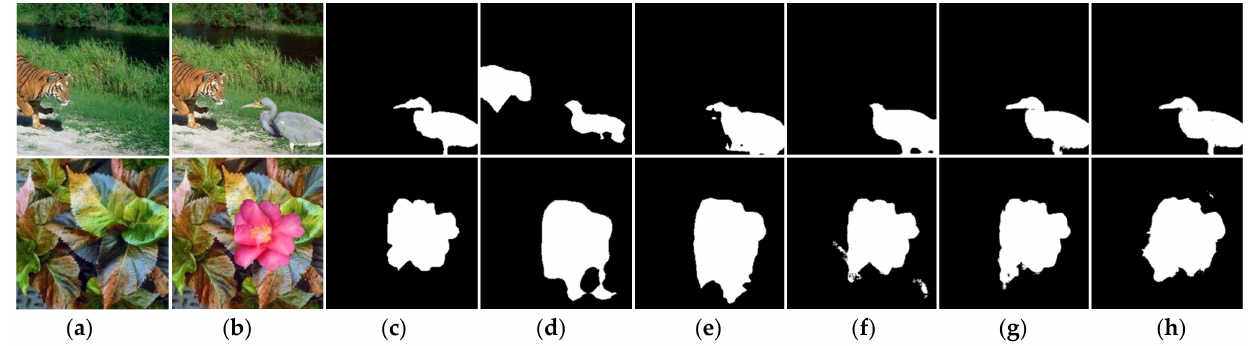
Figure 4. Ablation results of two images from CASIA1.0: ( a ) real images, ( b ) tampered images, ( c ) label image, ( d ) basic model, ( e ) basic model + SRM, ( f ) basic model + GAU, ( g ) basic model + SRM + GAU and ( h )